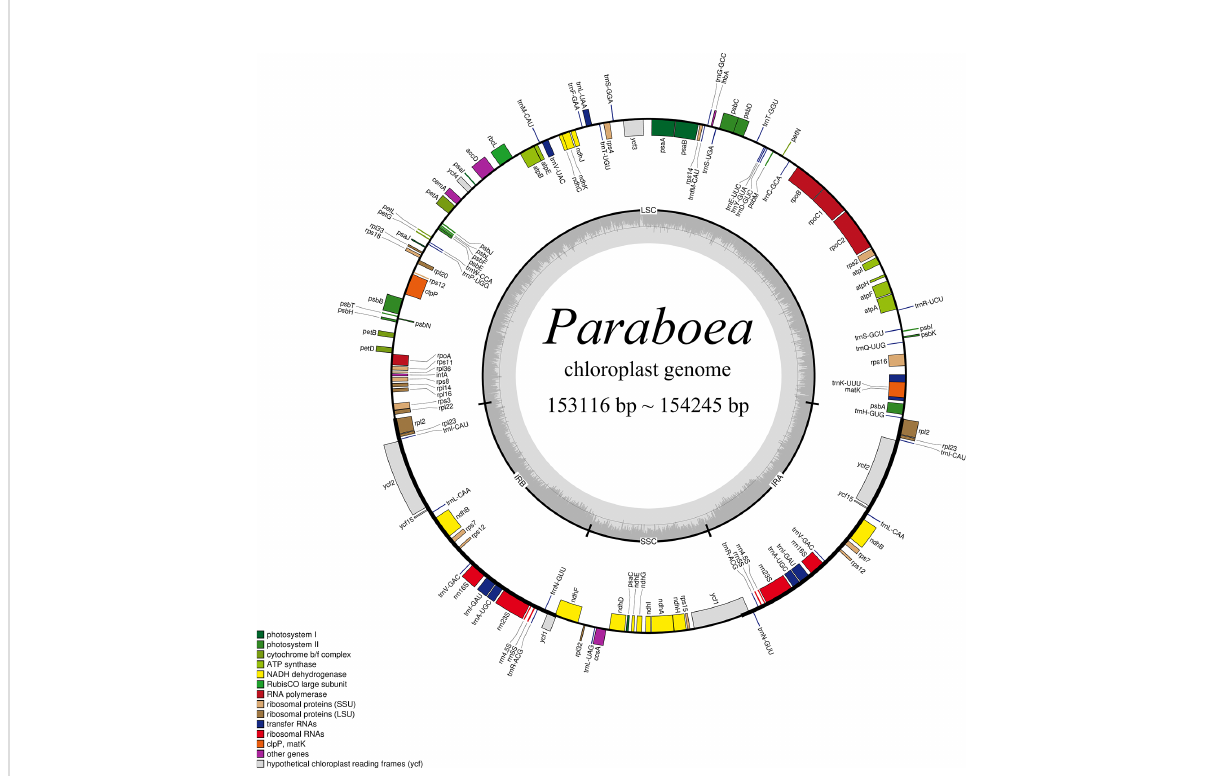
FIGURE 1 Structural map of the Paraboea chloroplast genome. Genes shown outside the outer circle are transcribed clockwise and those inside are transcribed counterclockwise. Genes belonging to different functional groups are color-coded. P. clavisepala is used as the template for Figure